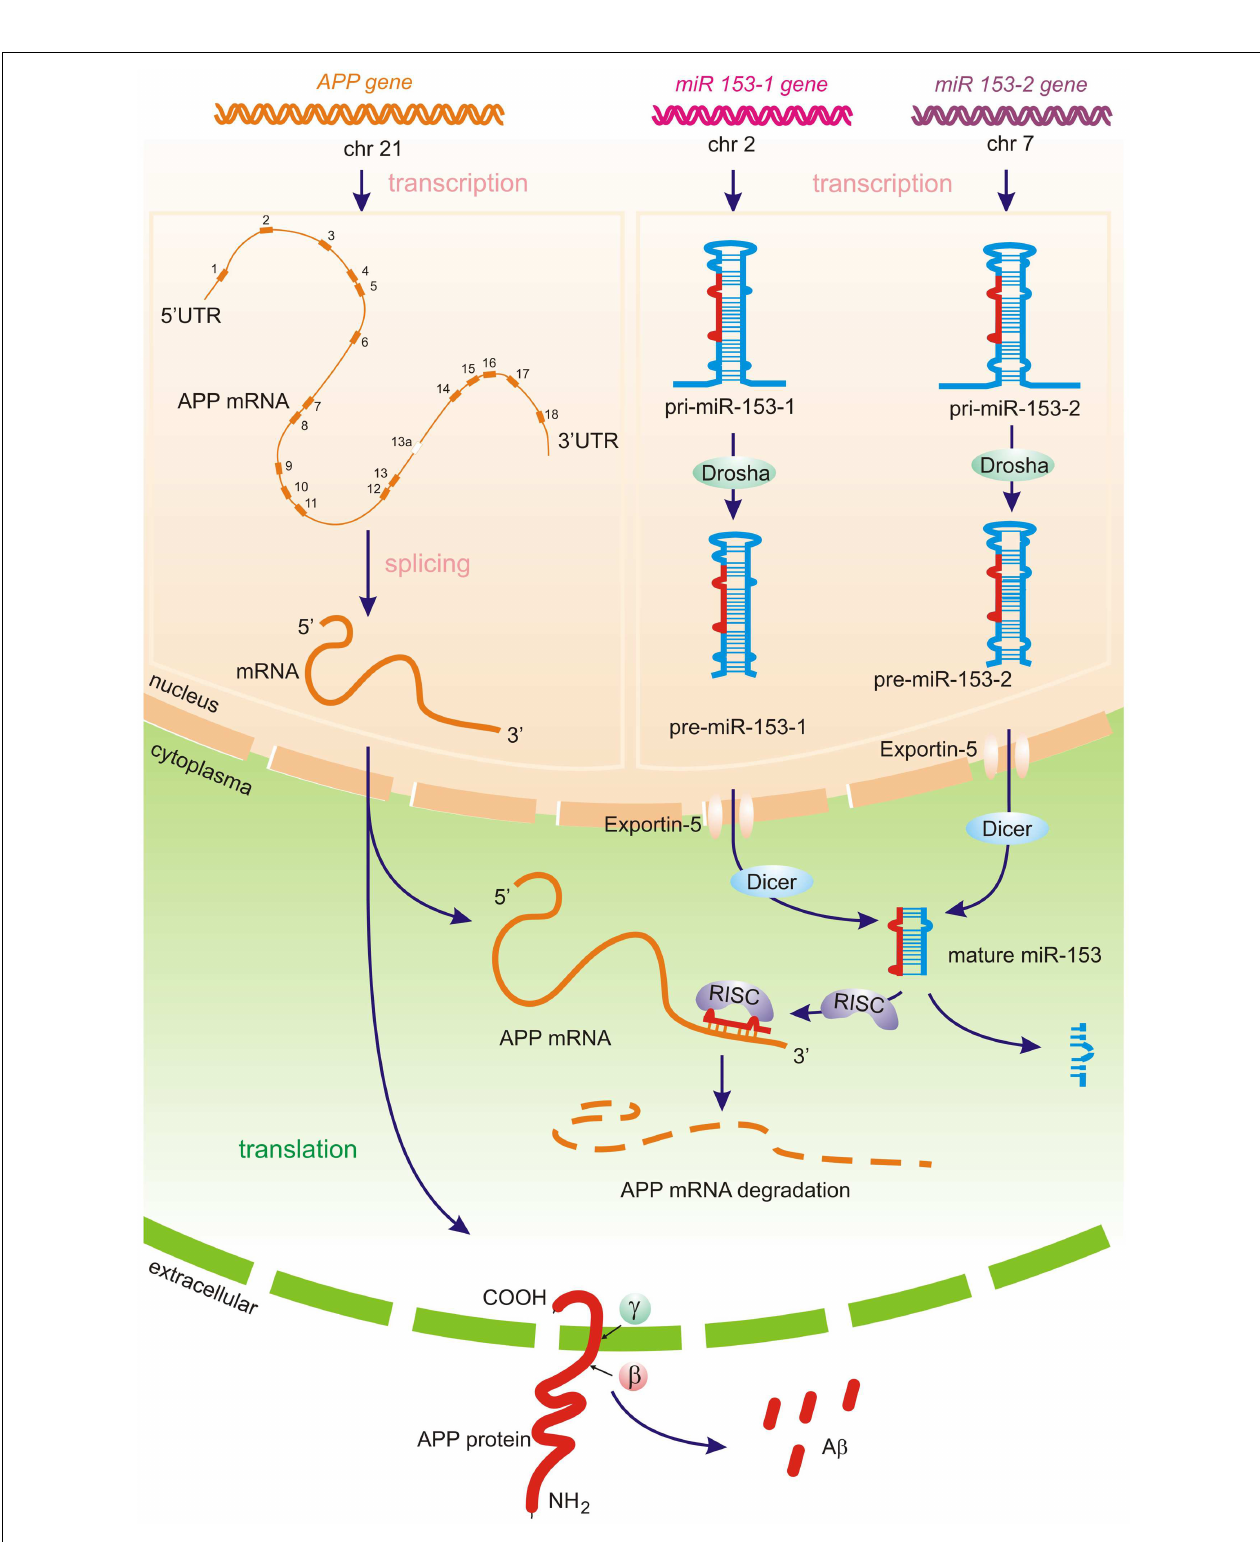
Dicer-complex generates the mature biologically active miR-153.The one strand of the miR-153 in the RISC complex (RNA-induced silencing complex) represses APP translation through APP 3 (cid:48) -UTR mRNA cleavage, whereas the other miRNA strand is degraded. Decreasing of miR-153 levels may lead to increased APP expression (Long et al., 2012) and further amyloid beta